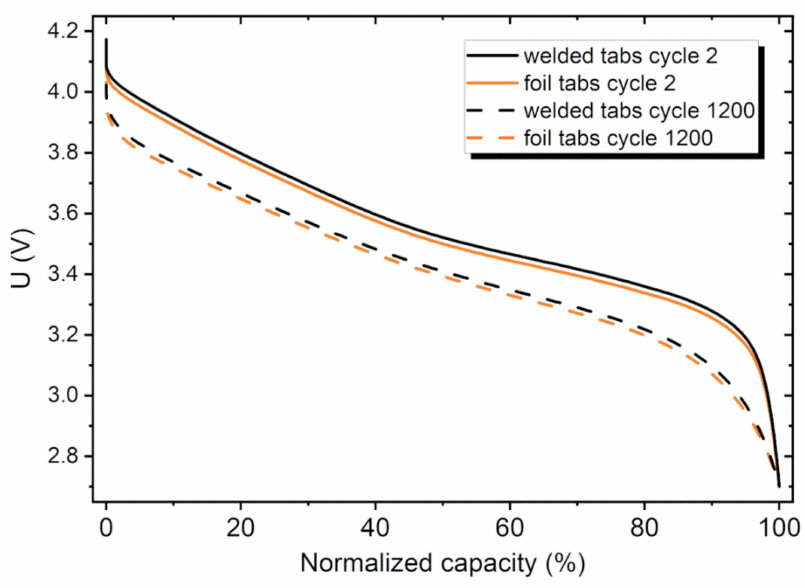
Figure 5. Voltage curves of fresh (cycle 2) and aged (cycle 1200) cells with welded and foil